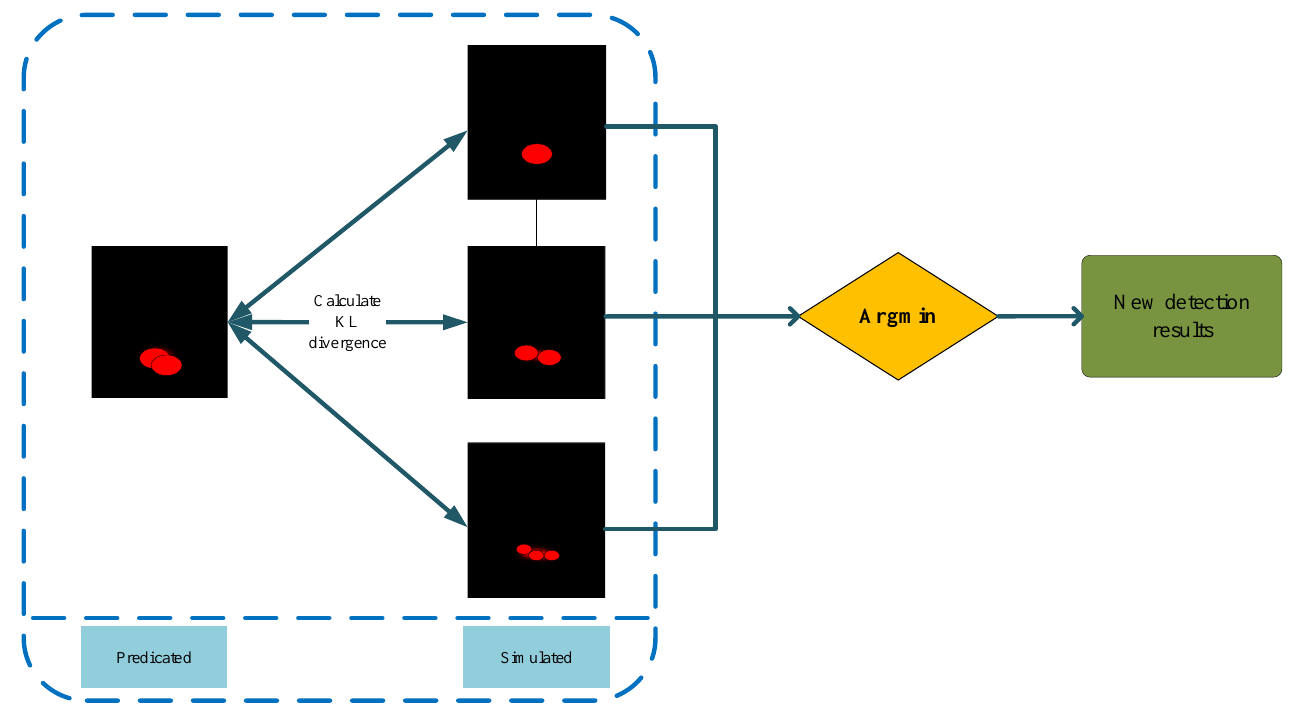
Figure 13. Flow chart of target number estimation method.